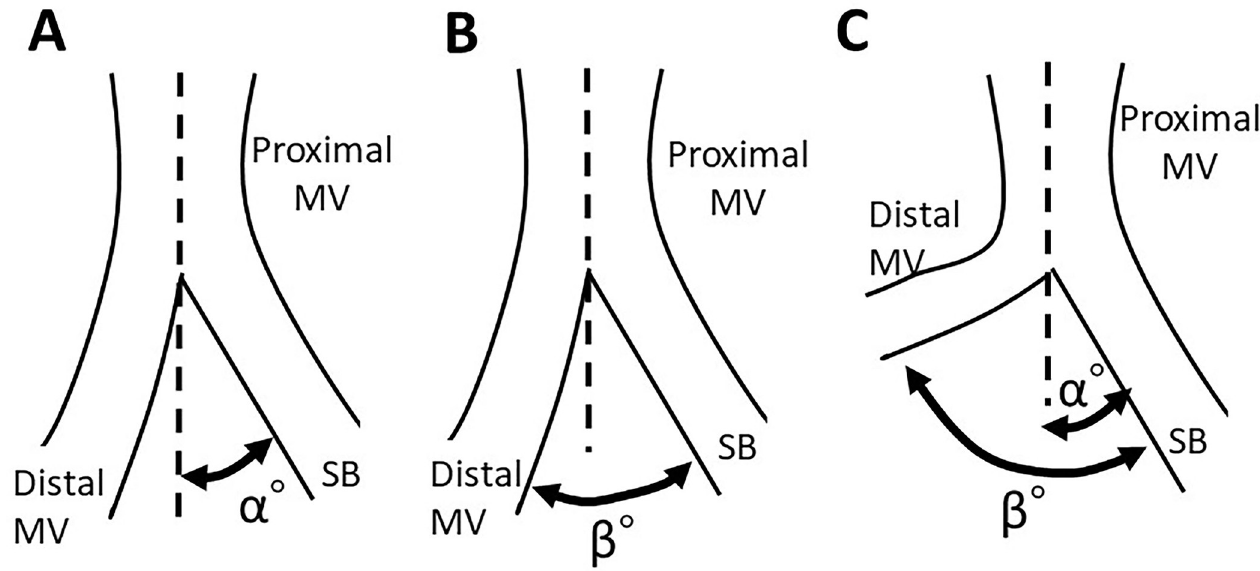
Fig 2. Definition of bifurcation angle (BA). A: Definition in in the Bifurcation Academic Research Consortium. Angle A: BA between proximal main vessel (MV) and side branch (SB), Angle B: BA between distal MV and SB, Angle C: BA between proximal and distal MV. B: Another assessment of BA related to MV and SB. BA- α : Angle between axis of proximal MV and SB. C: Discordance of BA assessments. In the case with large curvature on the MV side, the Angle B is assessed as a wide BA in which the angle change due to the curvature is included, although the BA- α is not affected by the curvature.